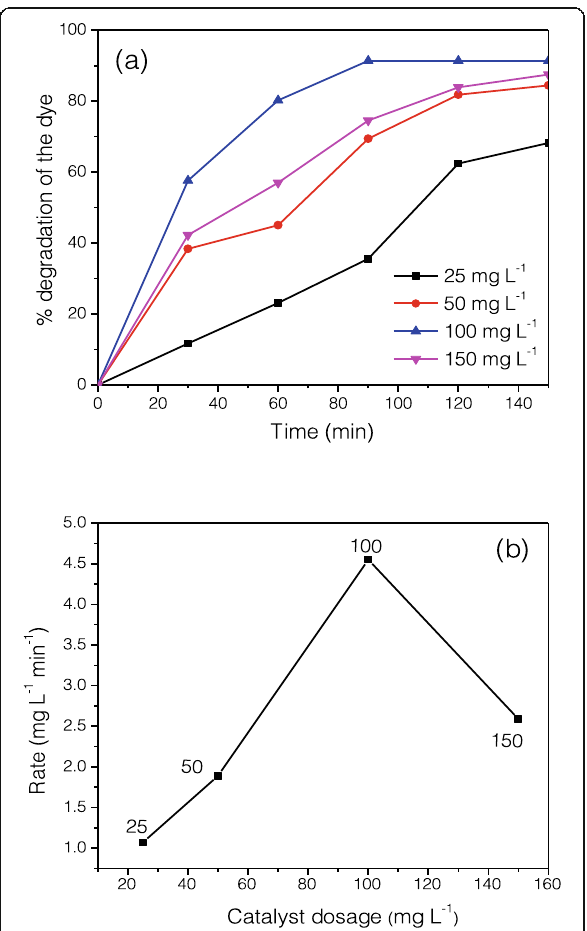
Fig. 10 ( a ) Catalyst loading on the rate of degradation of AR 6A by ZBT 3 at AR 6A 10 mg L − 1 and pH 6 ( b ) rate of the degradation on catalyst loading